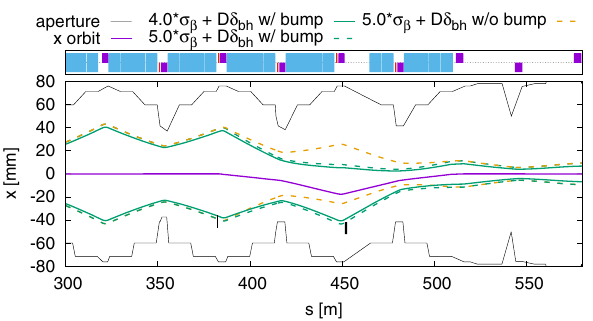
FIG. 5. Orbit bump (purple), beam envelope with (green) and without the orbit bump (orange) at the location of collimators (black rectangles). The machine aperture is given in black and the machine layout is shown in the top